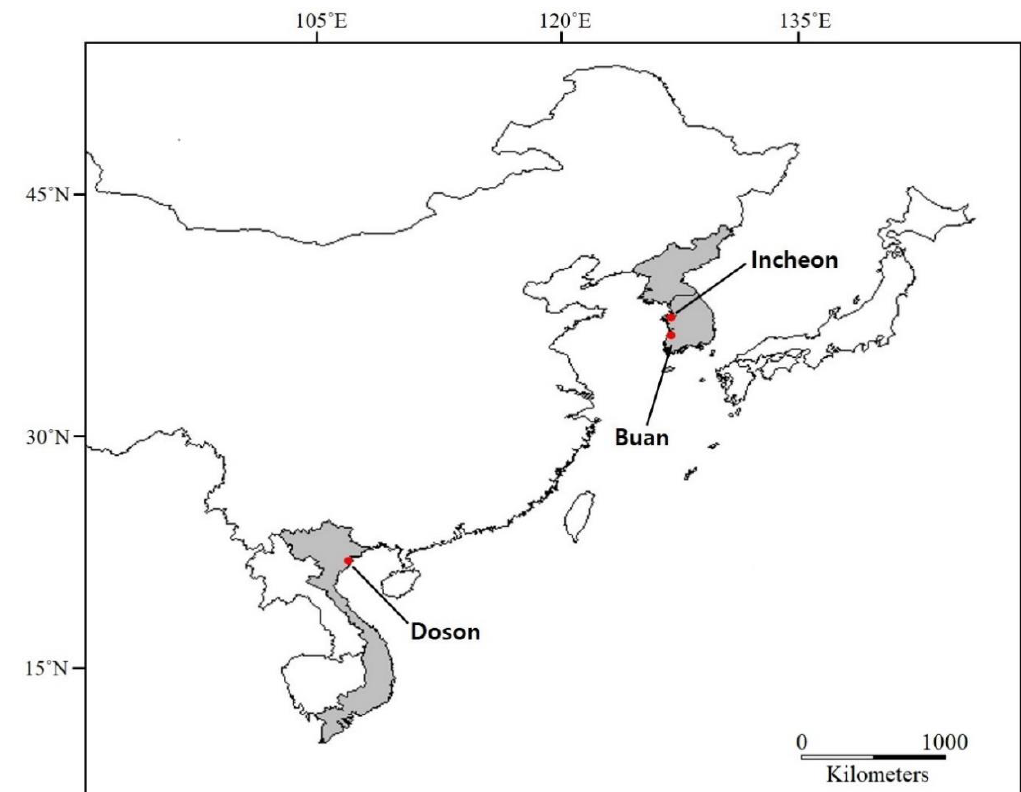
Figure 4. Map shows sampling localities in this study: Buan and Incheon (Korea) and Doson (Vietnam).